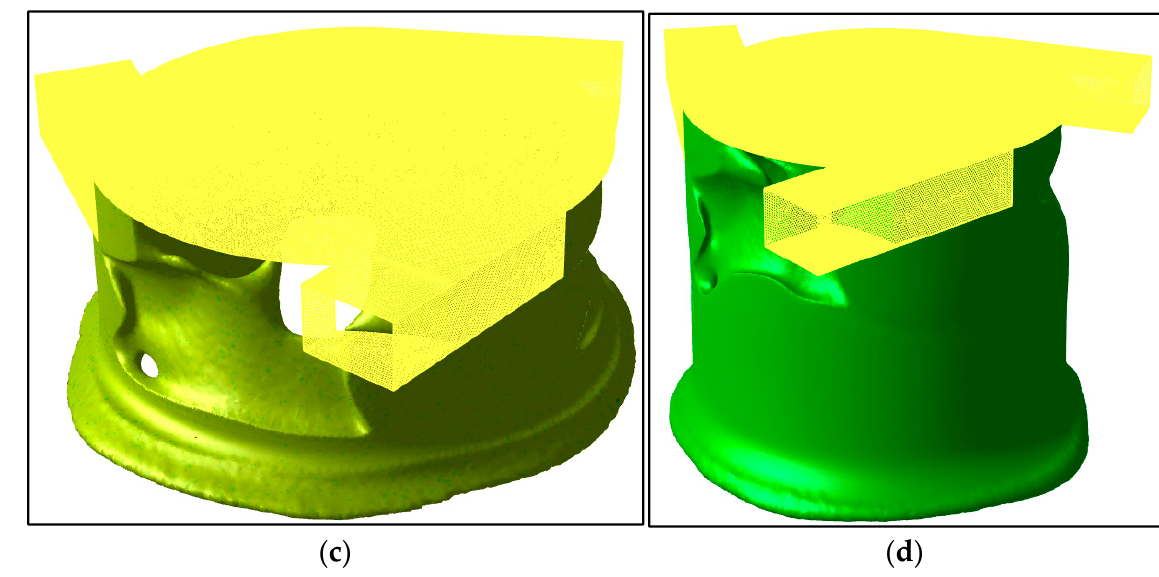
Figure 20. Mach number isosurface at M = 1 obtained for SVT with: ( a ) Ar ; ( b ) air ; ( c ) He ; and ( d ) CO 2 . Despite the similar Mach number isosurfaces, streamlines have a noticeable difference compared to SVT with the inner body (Figure 21). This is expressed by the decrease of the swirl radius (the right black circle).